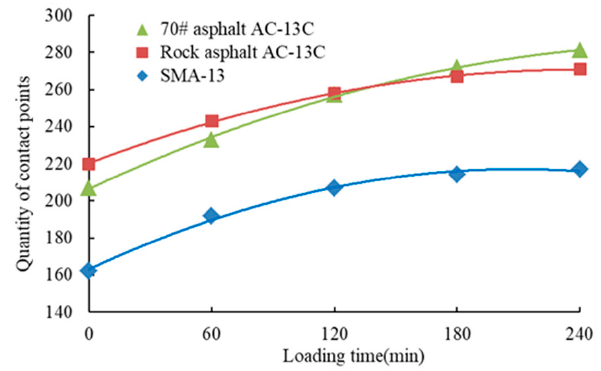
Figure 7. Gradual development of contact point.